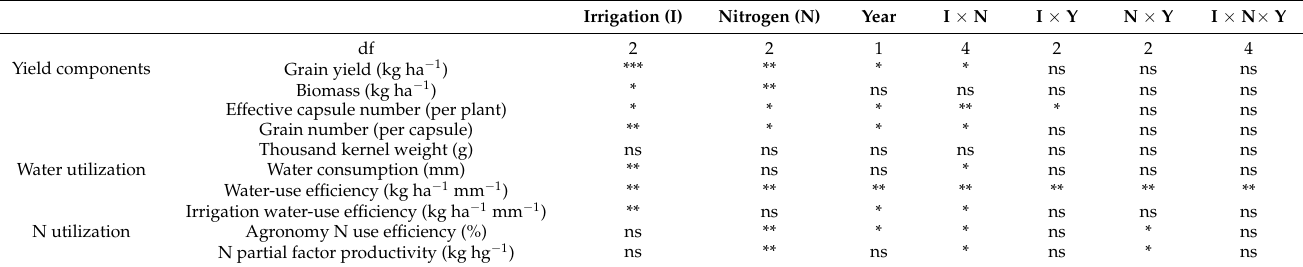
Table 1. Combined analysis of variance for traits related to yield components, water, and N utiliza- tion.